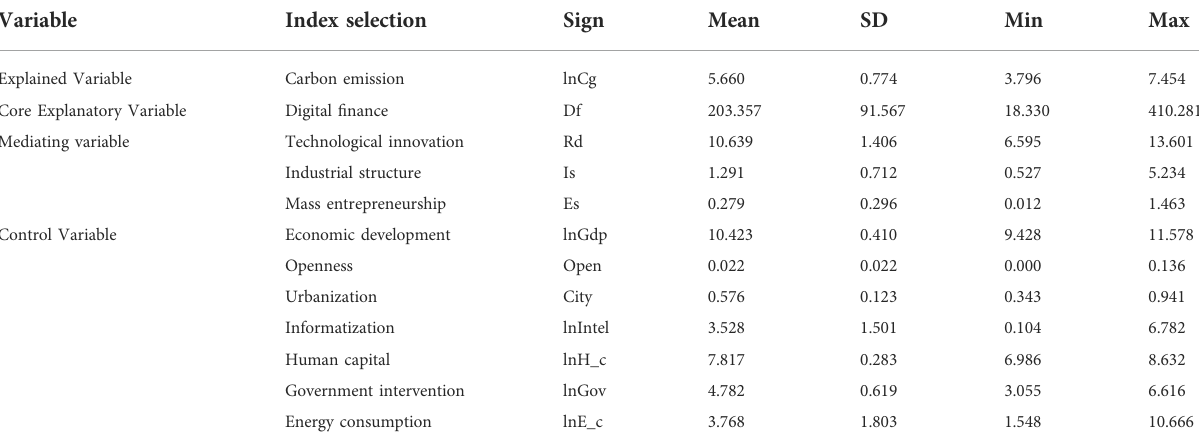
TABLE 1 Summary statistics of main variables.